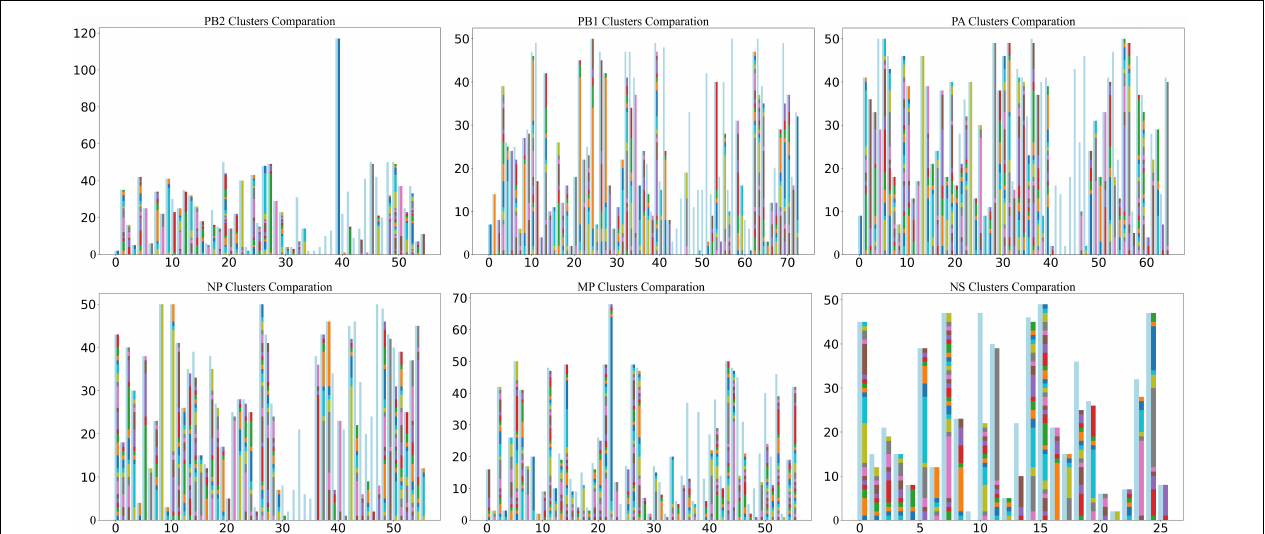
FIGURE 2 | Comparison of BRICH cluster results and typical clusters. The horizontal coordinate is the typical cluster number, and the vertical coordinate is the number of strains included. The light blue bars show the strains included in typical clusters, and the different colored bars on the right are the clusters calculated by the BRICH method. When all strains in a BRICH cluster can be found in a typical cluster, the bar representing the BRICH cluster corresponds to the typical cluster, as shown in the